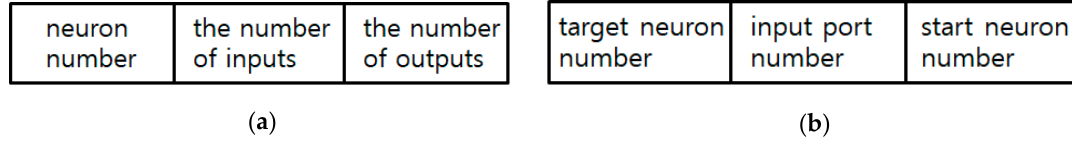
Figure 1. Overall methodology.